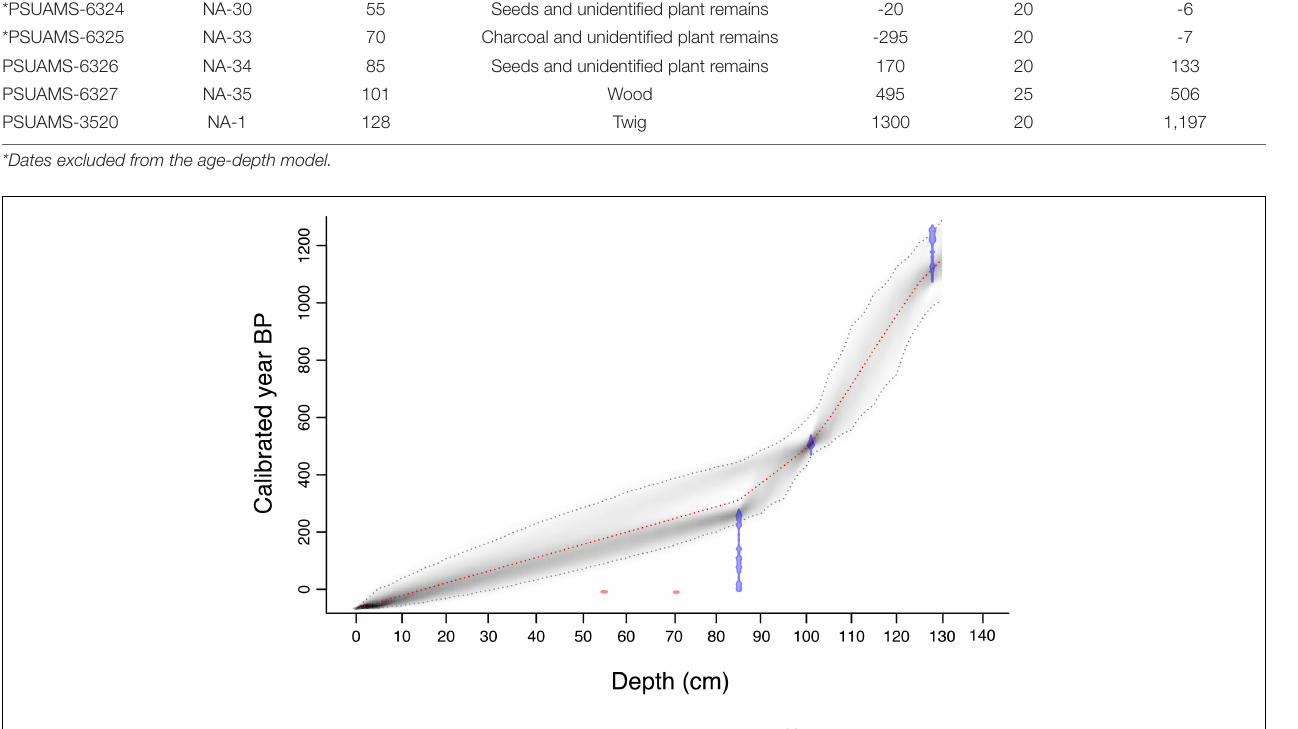
FIGURE 2 | Age-depth model from Namonte sediment core 22-IX-17-1B, southwest Madagascar. All 14 C dates pictured in blue were calibrated with SHCAL20 (Hogg et al., 2020), the gray line represents the 95% confidence interval, and the red dotted line is the best-fit model based on a weighted mean. 14 C dates indicated in red were excluded from the age-depth model. The sediment surface (-67 cal yr BP) was included in the Bayesian